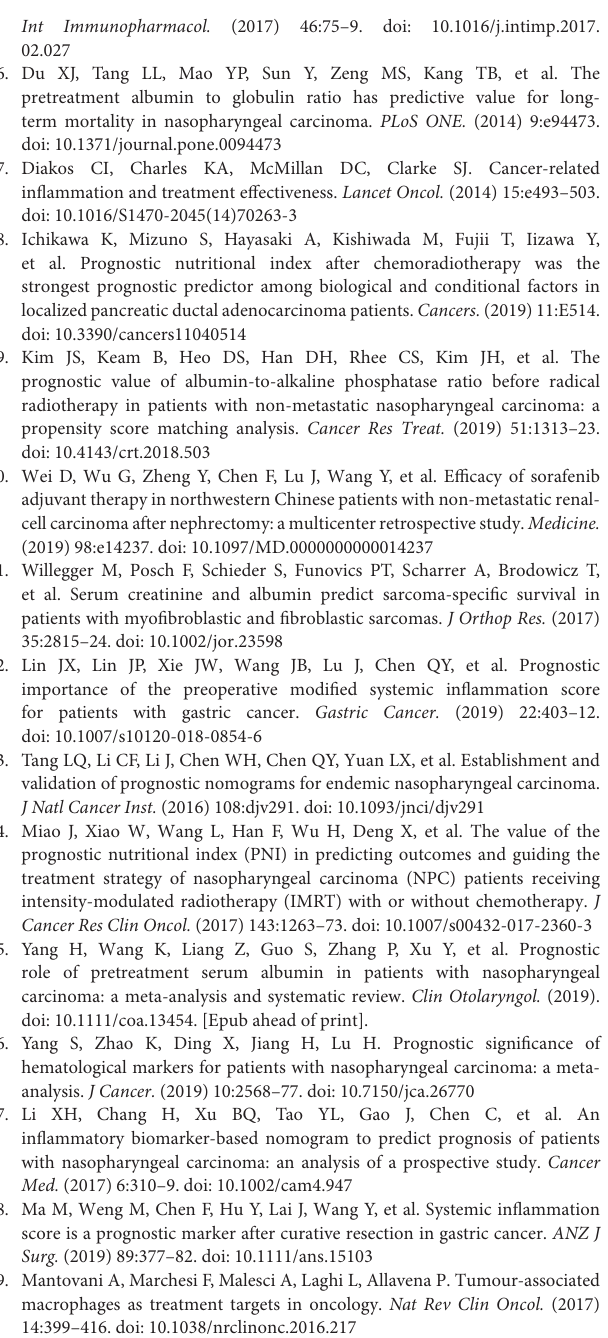
Figure S1 | Univariate and multivariate logistic regression analysis of clinical parameters and hemograms on the side effects in NPC patients. (A) Radiodermatitis. (B) Radiation stomatitis. (C) Skin pigmentation after radiotherapy. (D) Dysphagia. (E) Gastrointestinal reaction. (F) Innutrition. (G) Arrest of bone marrow. Table S1 | General character of NPC and Rhinitis cohort. Table S2 | Therapeutic regimens of NPC